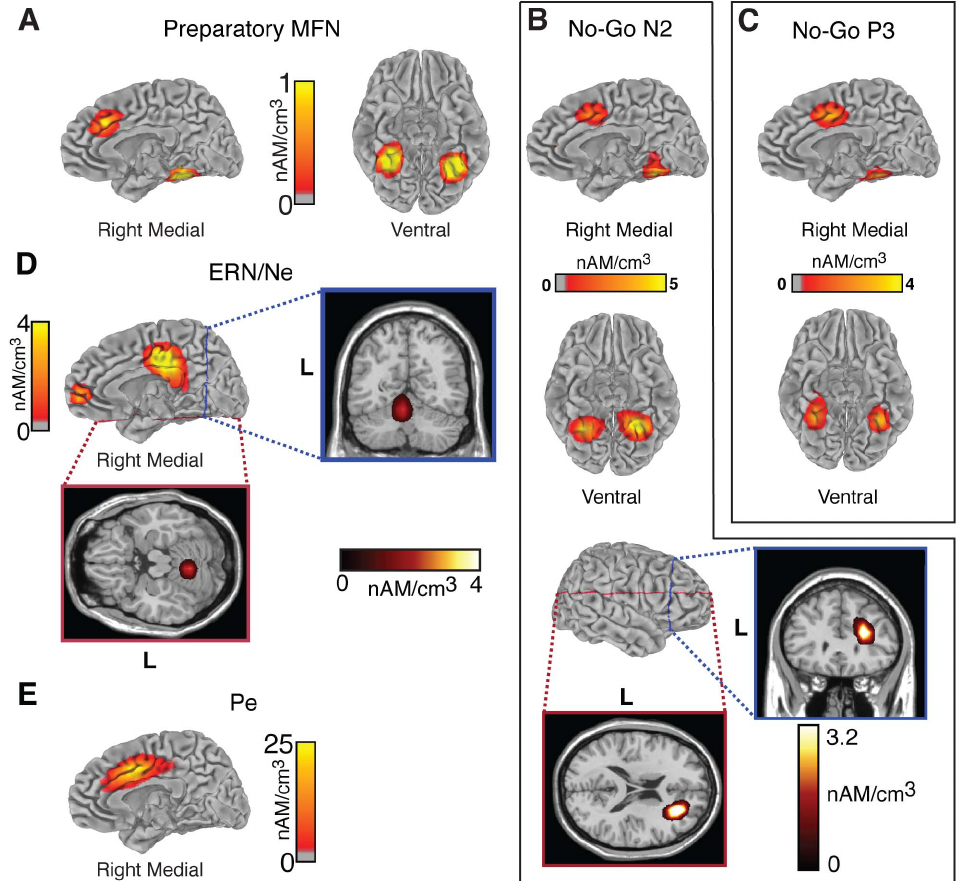
Figure 5. Estimated distributed source activity underlying the ERPs of interest. Source estimations are plotted on the medial and ventral surfaces of the brain in real space (i.e., image left = anatomical left). ( A ) Sources of the preparatory MFN, measured 488 ms after the onset of the preview display. ( B and C ) Sources of the No-Go N2 and P3, measured 268 ms and 392 ms after the onset of the Go/No-Go signal. ( D and E ) Sources of the error related negativity and error positivity (ERN/Ne and Pe), measured 96 ms and 348 ms after the onset of the end-of-trial response